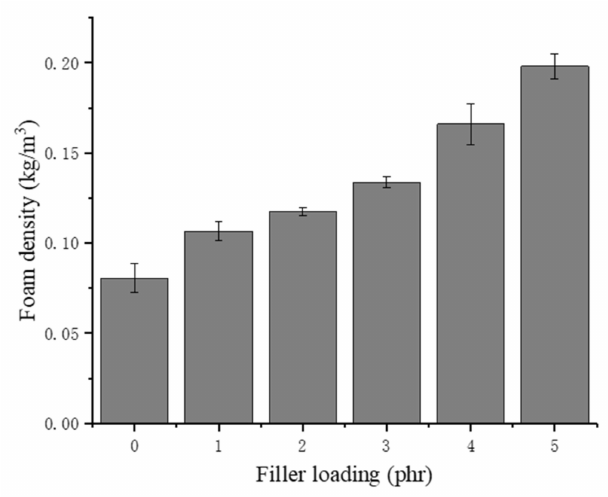
Figure 5. Density of chitin–NRLF